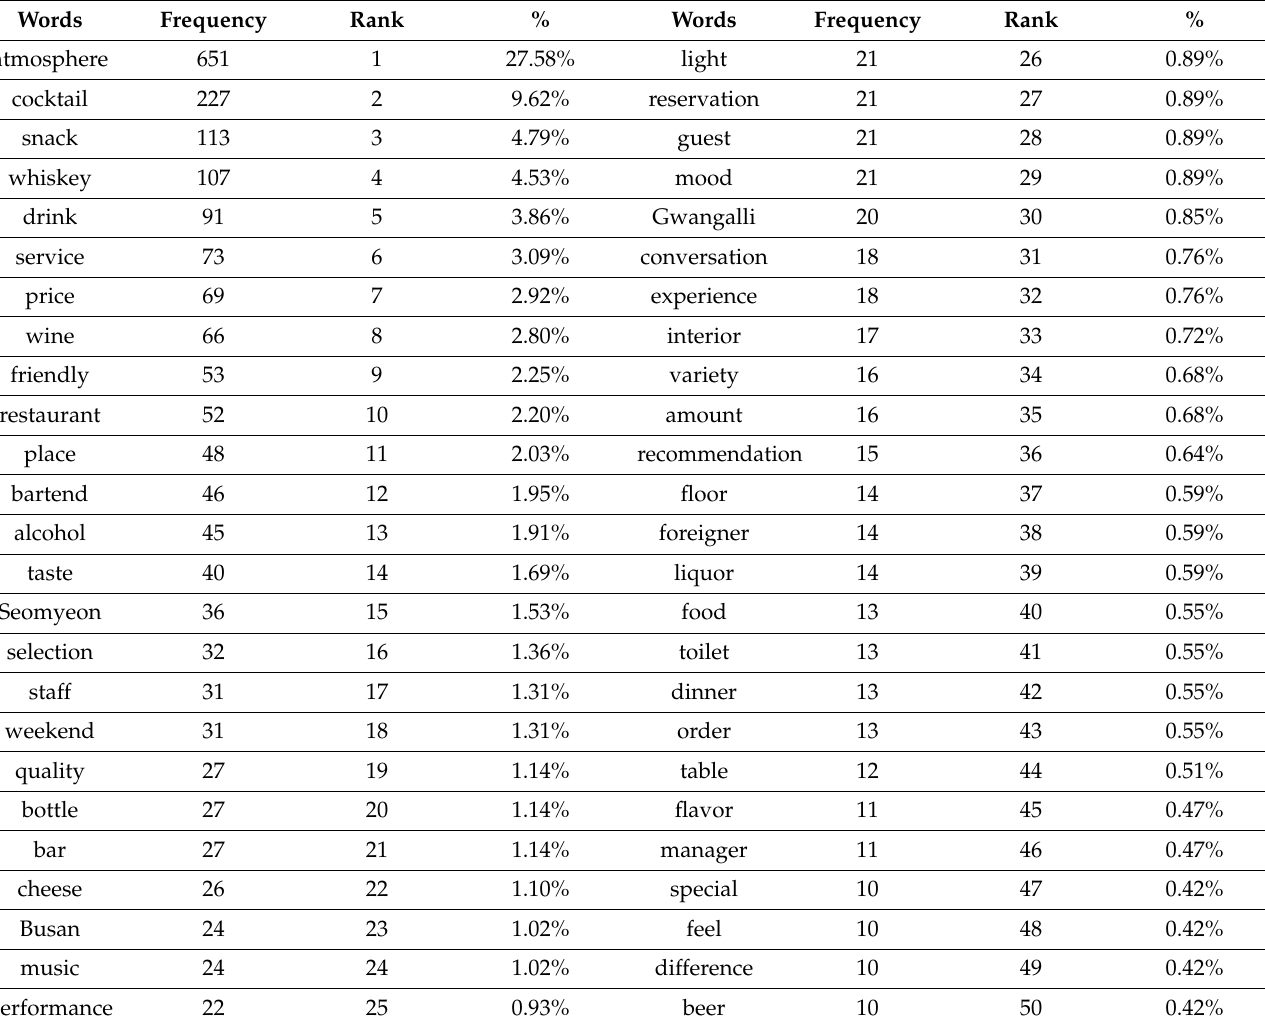
Table 2. Frequencies and ranks of the top 50 frequently used